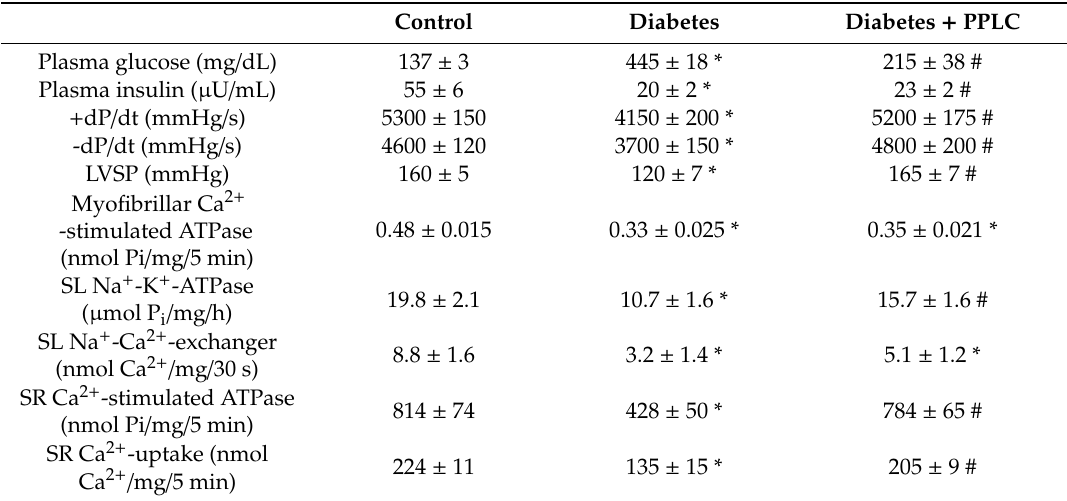
Table 5. Glucose / insulin levels, hemodynamic parameters and subcellular activities of control, diabetic and propionyl-L-carnitine-treated diabetic animals.